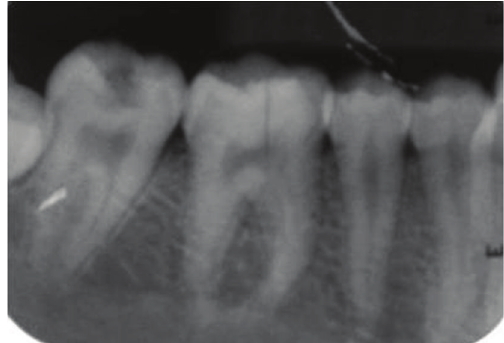
Figure 8: Preoperative periapical radiograph with 46 revealing radiolucent fracture line in the coronal aspect of the tooth.